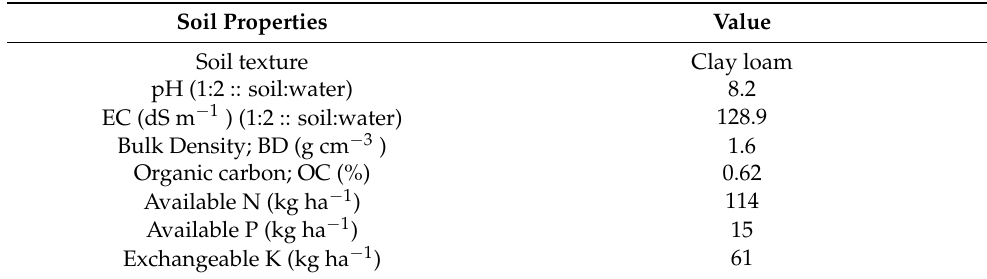
Table 1. Basic initial soil properties and nutrient status (0–15 cm depth) of the study